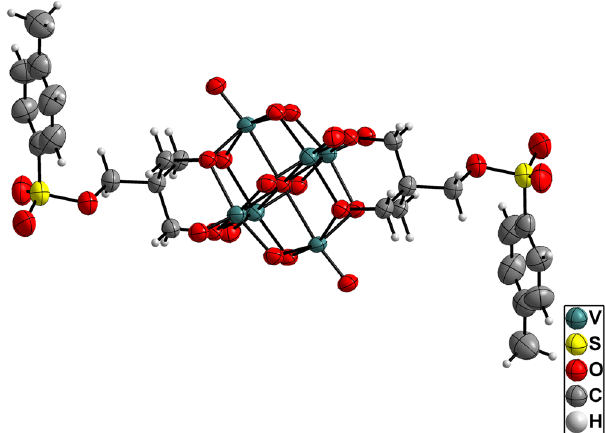
Figure 2. ORTEP drawing of the anionic cluster of compound 1 . Thermal ellipsoids are drawn at the 50% probability level. Colour scheme: V = teal; S = yellow; O = red; C = grey; H = light grey.